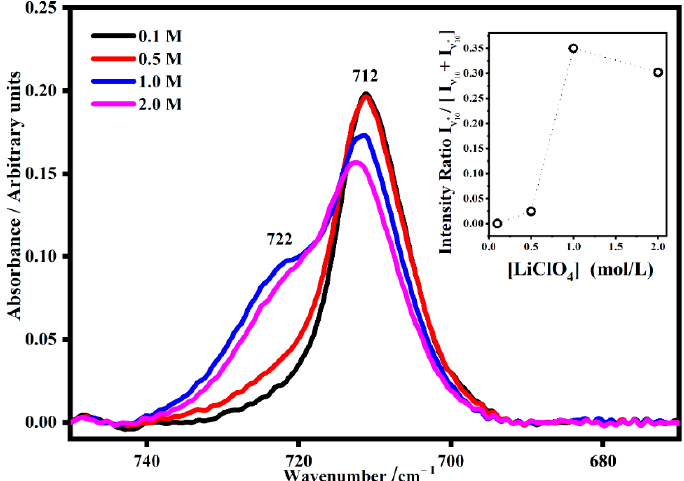
Figure 5. The IR mode denominated ν 10 assigned to the symmetric ring deformation of propylene carbonate (712 cm − 1 ) and its satellite band ( ν 10 *) due to the symmetric ring deformation interaction with lithium ions (722 cm − 1 ) in PMMA-Li-PC gel polymer electrolyte at different salt concentrations: 0.1 M, 0.5 M, 1 M and 2 M. In the inset, the trend of the intensity ratio I ν 10* /[I ν 10 + I ν 10* ] as a function of the salt concentrations.